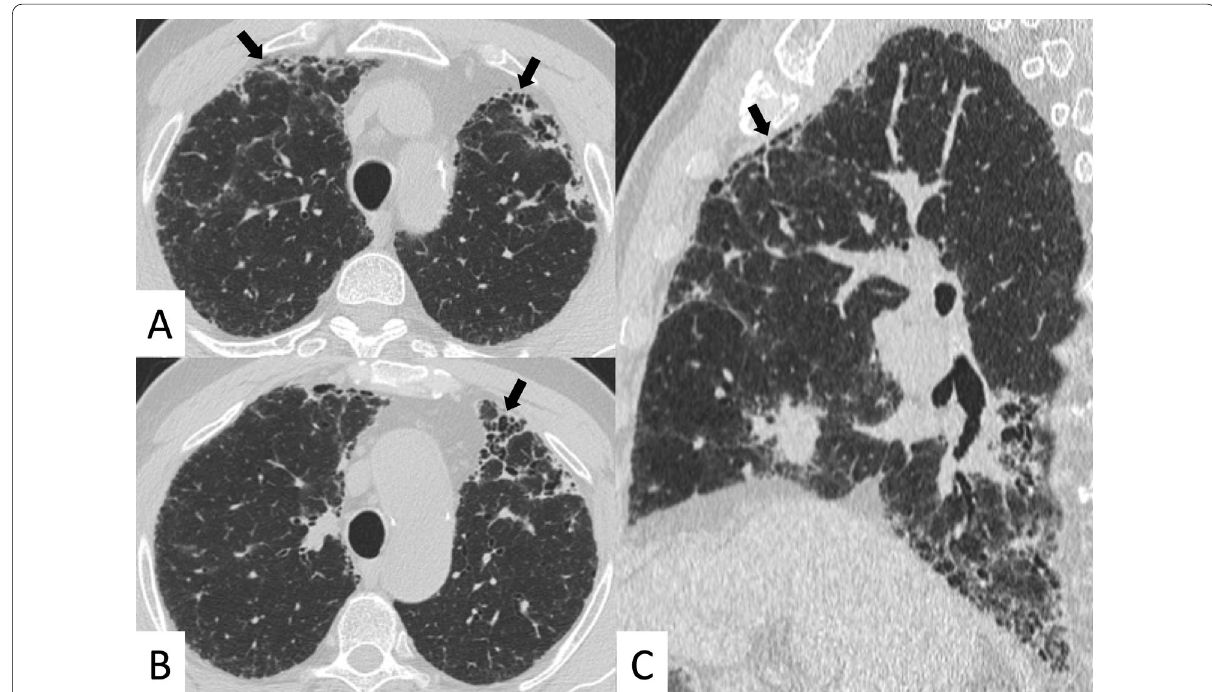
Fig. 4 Anterior upper lobe sign in a patient with RA. It consists of a particular fibrosis distribution, most concentrated along the anterior side of the upper lobes; it can be appreciated on axial (black arrows in A , B ) and sagittal MPR image (black arrow in C